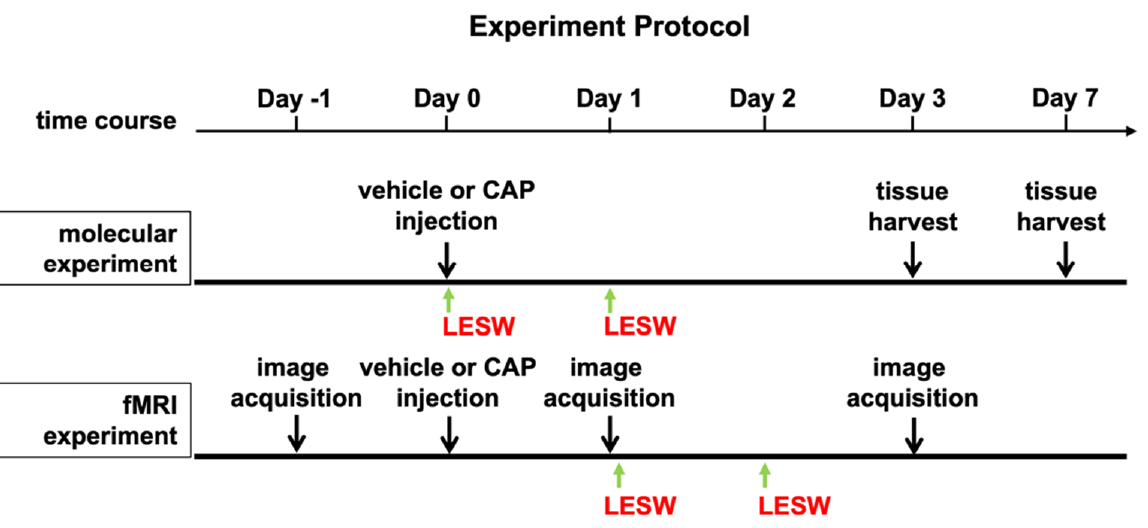
Figure 8. Schematic diagram of experimental protocol. For molecular experiments, the rats received ESWT immediately and 24 h after capsaicin injection. For BOLD fMRI experiments, all the rats received fMRI image acquisition one day before capsaicin injection. One day after intraprostatic capsaicin or vehicle injection, the rats received second fMRI scan. Li-ESWT group received two times of treatment right after and 24 h after second image acquisition. Three days after capsaicin injection the third time fMRI scan was conducted.